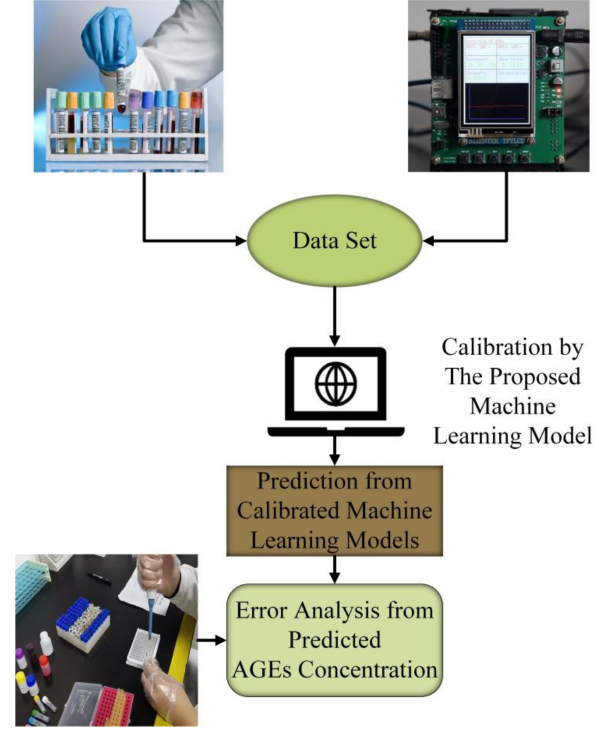
Figure 1. Working process of the proposed